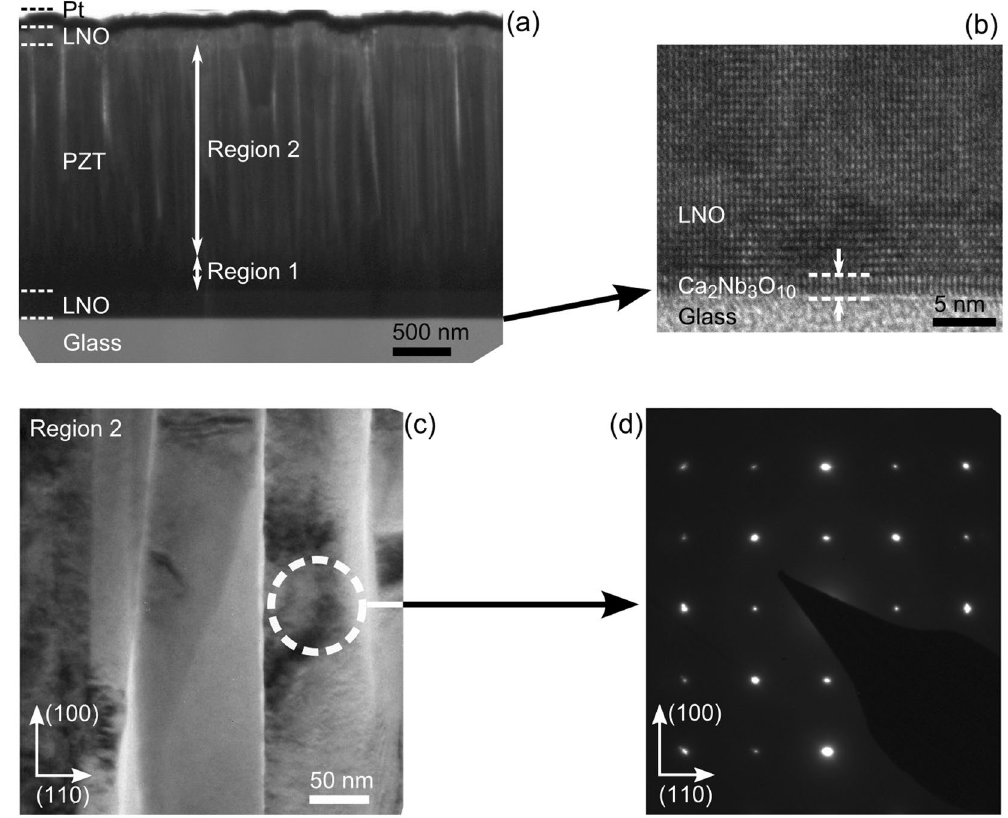
Figure 3. TEM images. ( a ) Cross-section of the H 20Hz heterostructure in which PZT layer was first deposited at 5 Hz repetition frequency (region 1 with dense packing) and then 20 Hz repetition frequency (region 2 with separated columns). ( b ) A magnified image of Ca 2 Nb 3 O 10 nanosheet and glass interface. ( c ) A magnified image of the columns from region 2 of the PZT film. ( d ) Selected area electron diffraction pattern recorded for one of the column confirming an epitaxial